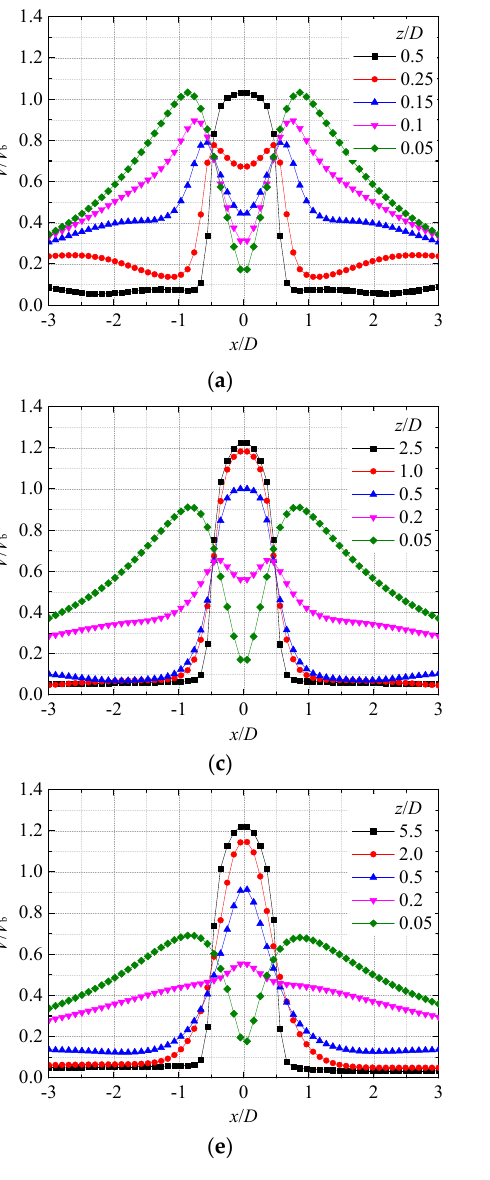
Figure 8. Radial profile development of the normalized mean axial velocity V / V b at various impinging height: ( a ) H / D = 1; ( b ) H / D = 2; ( c ) H / D = 3; ( d ) H / D = 4; ( e ) H / D = 6; ( f ) H / D = 8.